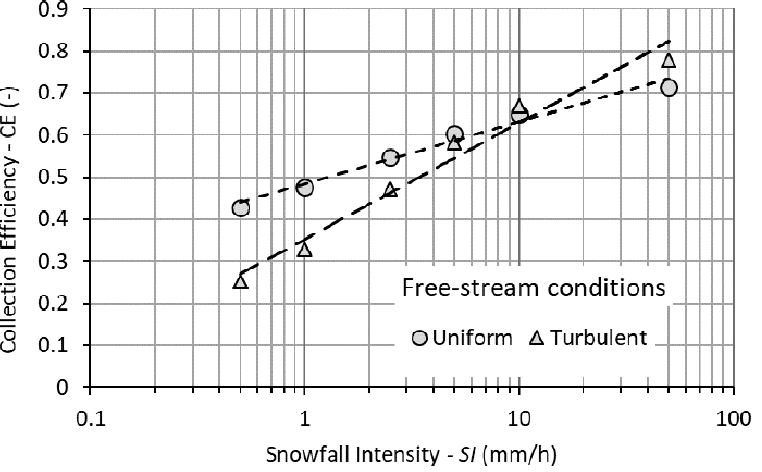
Figure 10. CE curves as a function of SI , obtained under uniform and turbulent free-stream conditions at U ref = 2.5 m s −1 .